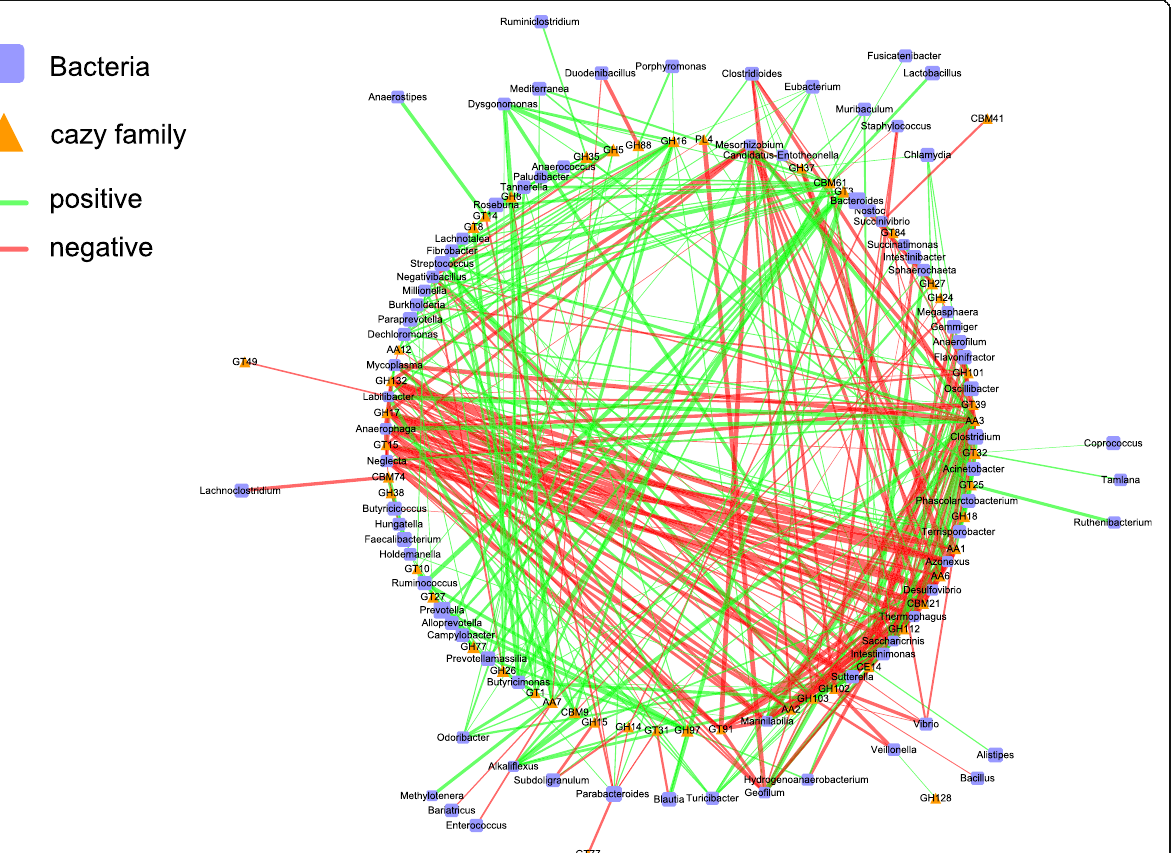
Fig. 7 Network of correlations between the bacteria and CAZyme families that were changed significantly by the dietary fibers. The network is displayed graphically in the form of nodes (bacteria or CAZyme families) and lines (significant interactions among nodes). The Spearman correlation coefficient reveals the association between the changes in bacteria genera and the expression of the CAZyme family genes that changed significantly in at least one experimental group (SCC > 0.5 or < − 0.5 and p < 0.05). The lines ’ colours represent two kinds of correlation: green for positive correlation and red for negative